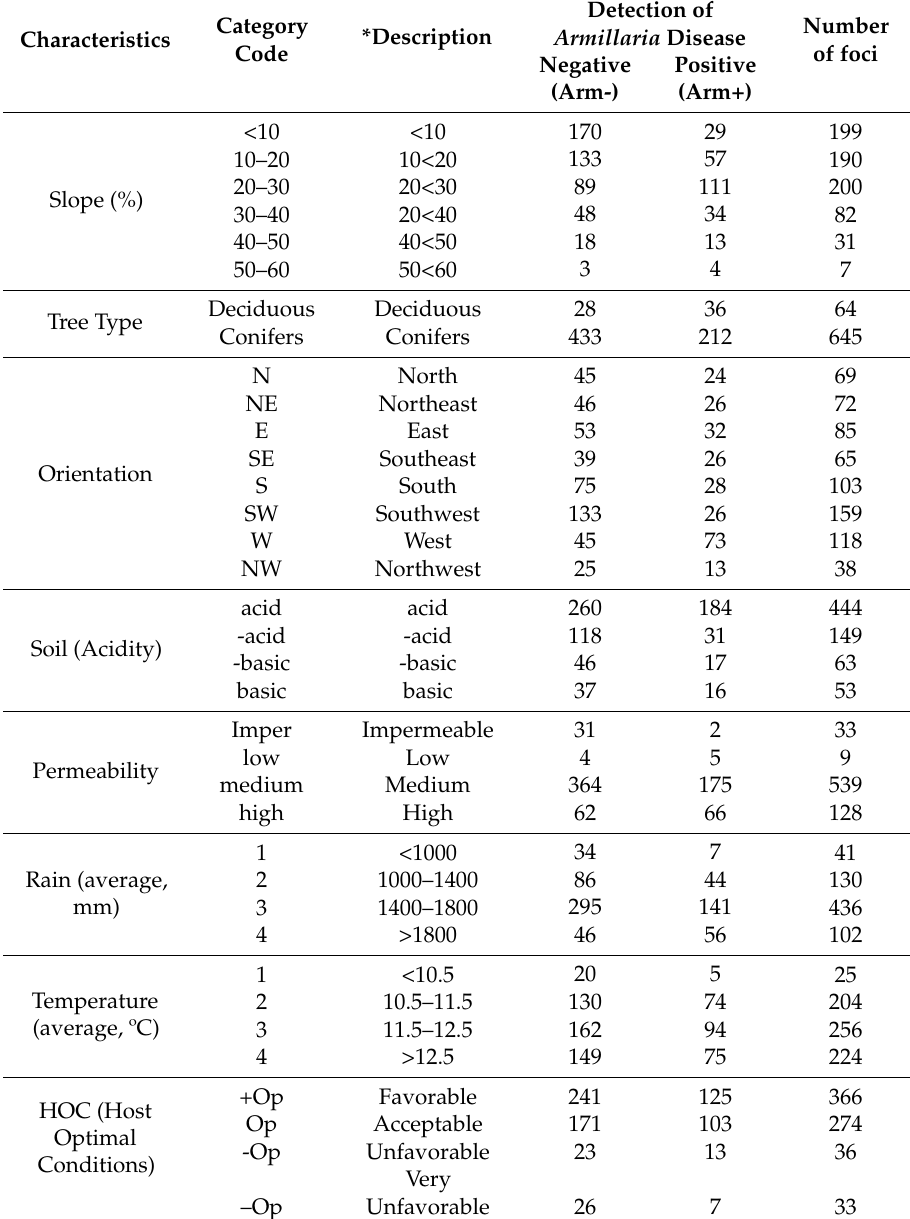
Table 2. Characteristics of the plots included in this